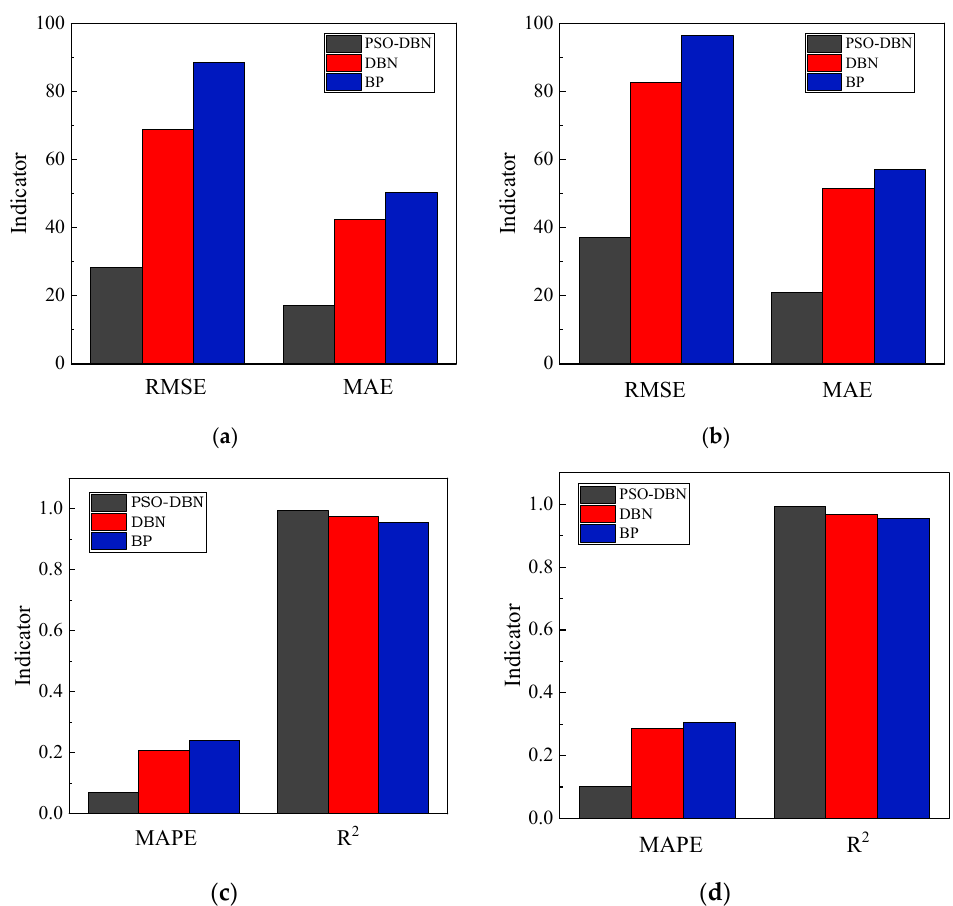
Figure 11. Models Comparison and Analysis:( a ) RMSE and MAE for training data; ( b ) RMSE and MAE for testing data; ( c ) MAPE and R 2 for training data; and ( d ) MAPE and R 2 for testing data. Table 6. Comparison of evaluation metrics between PSO-DBN model and single DBN model (a).